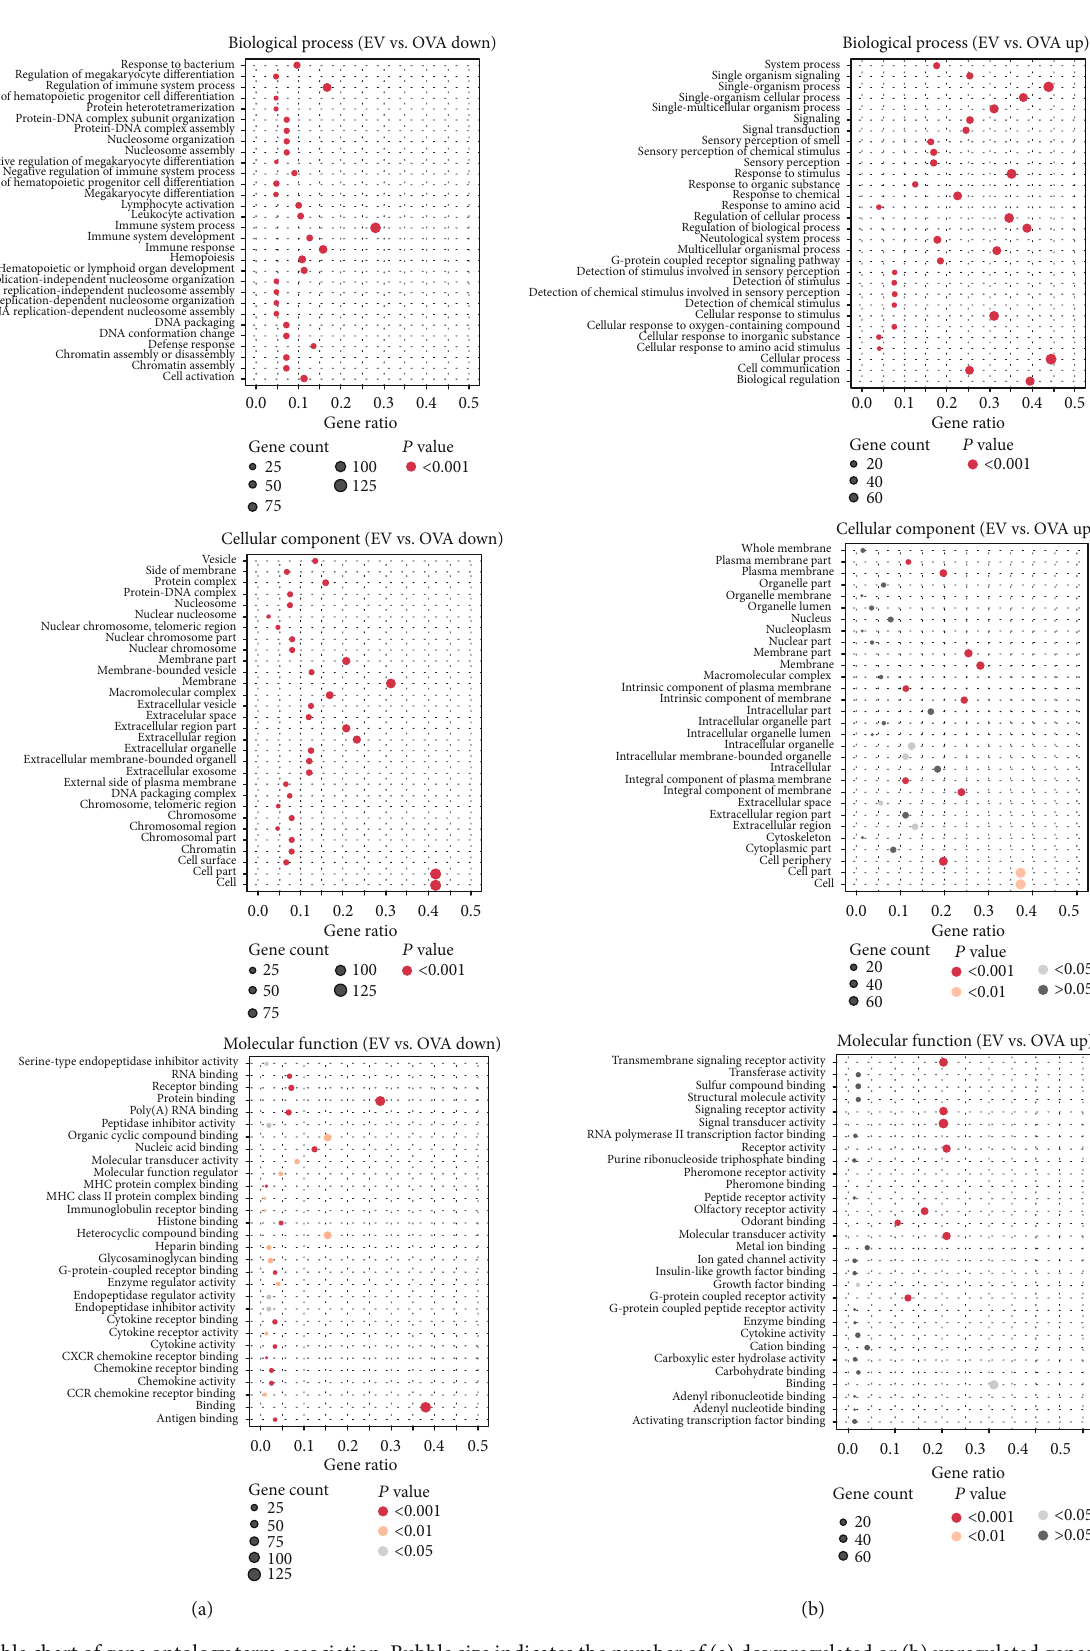
Figure 6: Bubble chart of gene ontology term association. Bubble size indicates the number of (a) downregulated or (b) upregulated genes for the corresponding